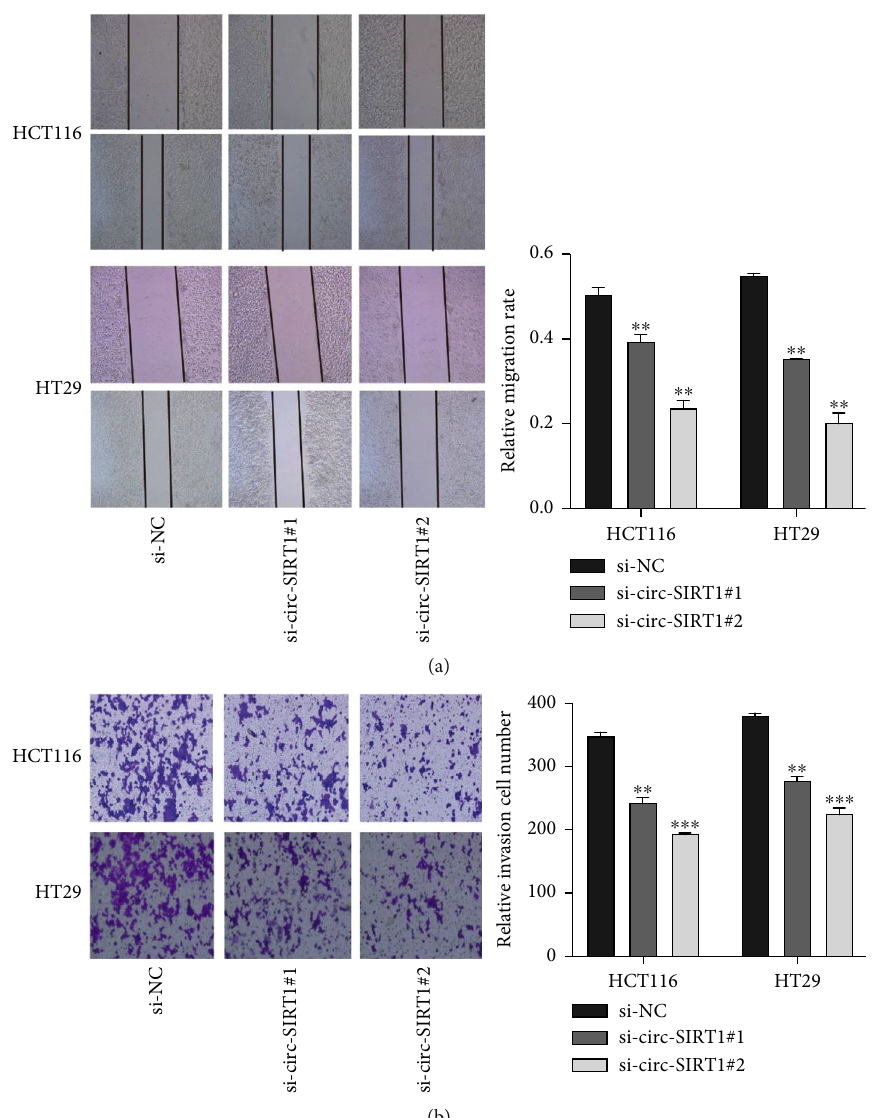
Figure 3: The e ff ect of si-RNA knocking down circ-SIRT1 on the migration and invasion of HCT116 and HT29 cells. Knockdown of circ- SIRT1 has an inhibitory e ff ect on the migration ability of HCT116 and HT29 cells (a). Knockdown of circ-SIRT1 inhibits the invasion ability of HCT116 and HT29 cells (b). ∗ stands for P < 0 : 05 , ∗∗ stands for P < 0 : 01